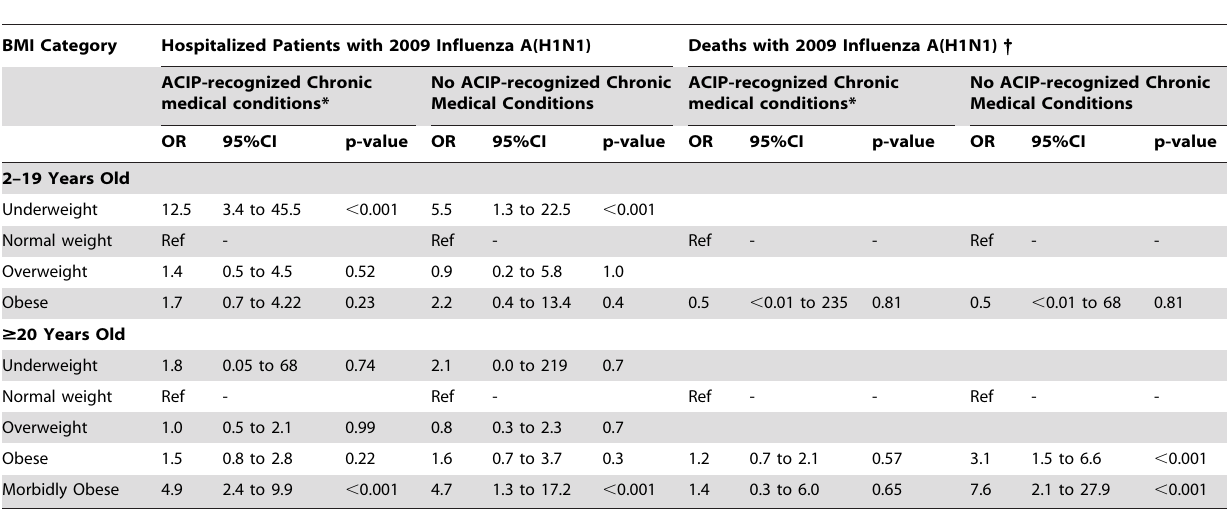
Table 2. Odds Ratio of BMI category for patients hospitalized or deaths with 2009 pandemic influenza A(H1N1) compared to